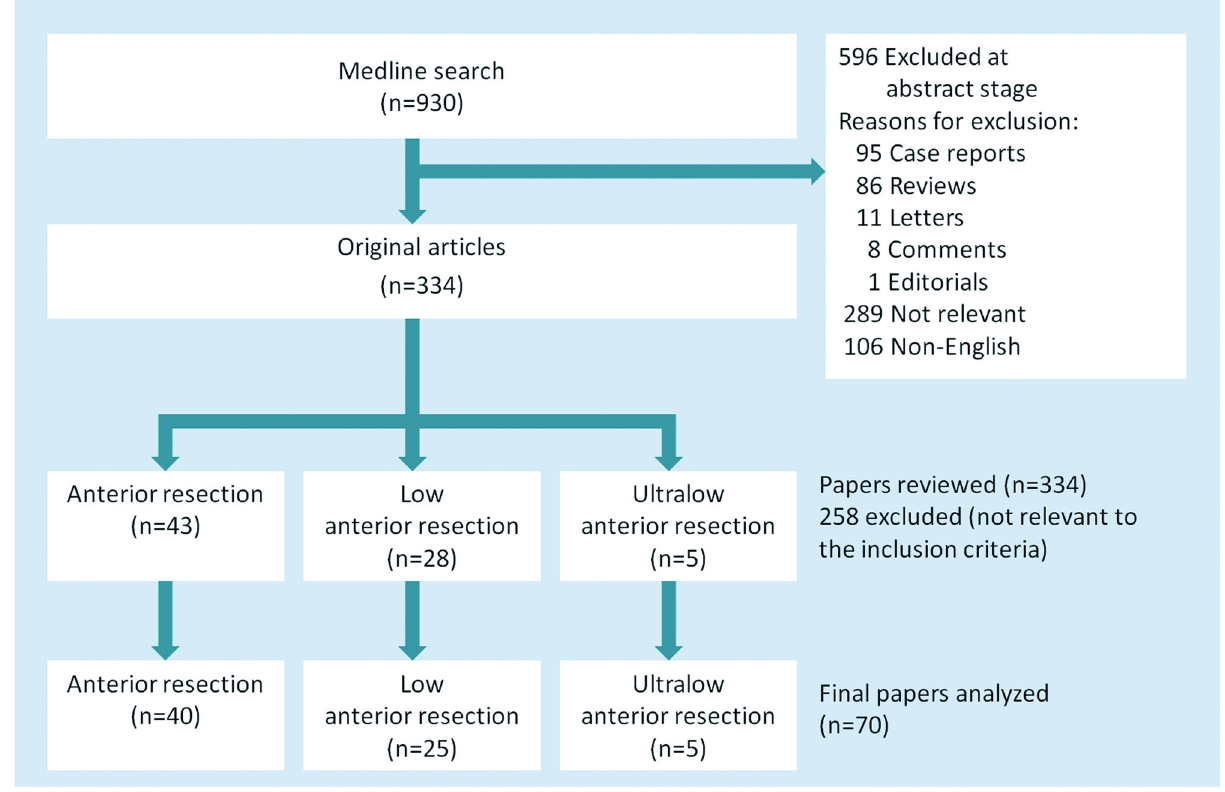
Figure 1. Literature search, review, and